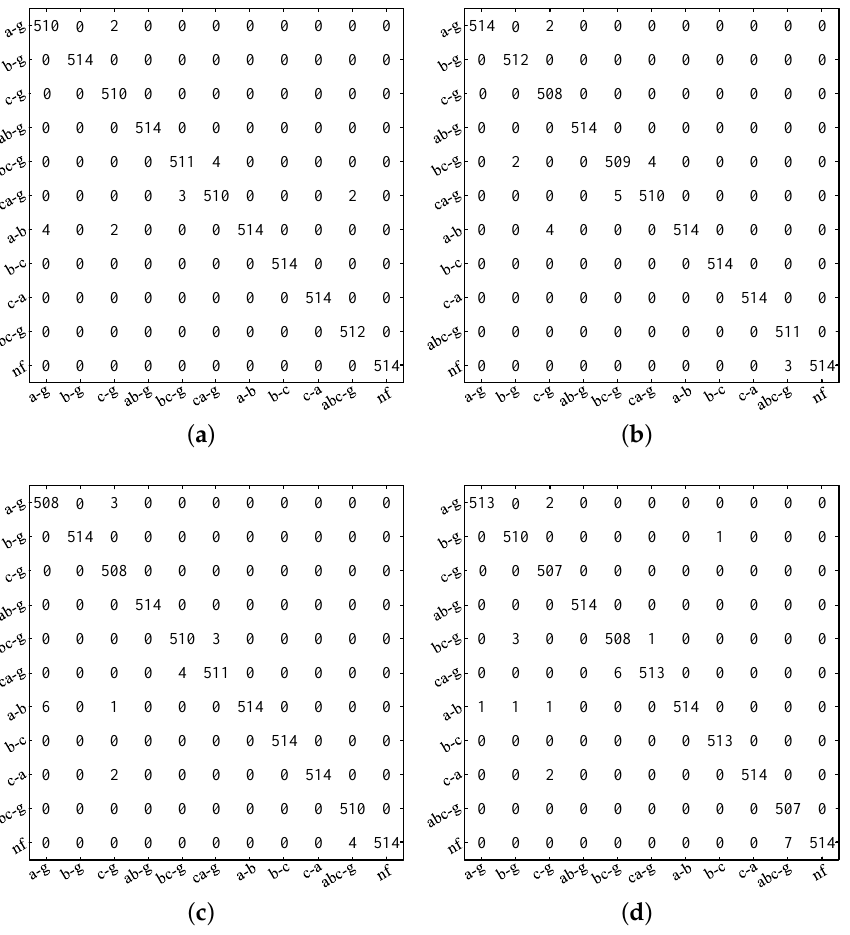
Figure 11. Confusion matrix of the proposed classifier for the ( a ) grid-tied radial, ( b ) grid-tied loop, ( c ) islanded radial, and ( d ) islanded loop mode operation of the considered